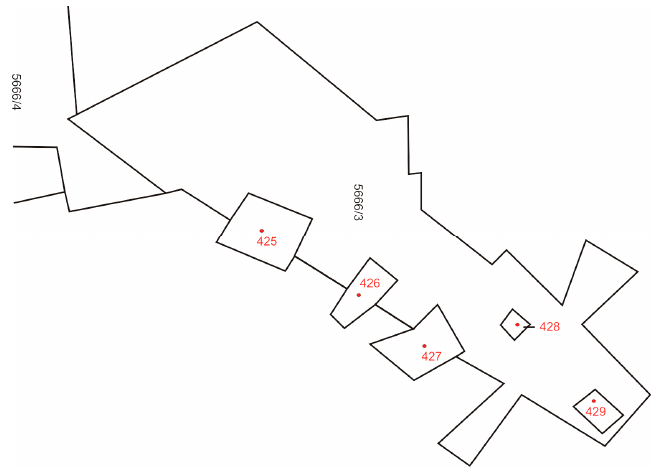
Figure 2. 2D visualization of the boundaries of underground construction for the archeological park in Pavlov. Every component of the construction located above ground has to exist on a separate